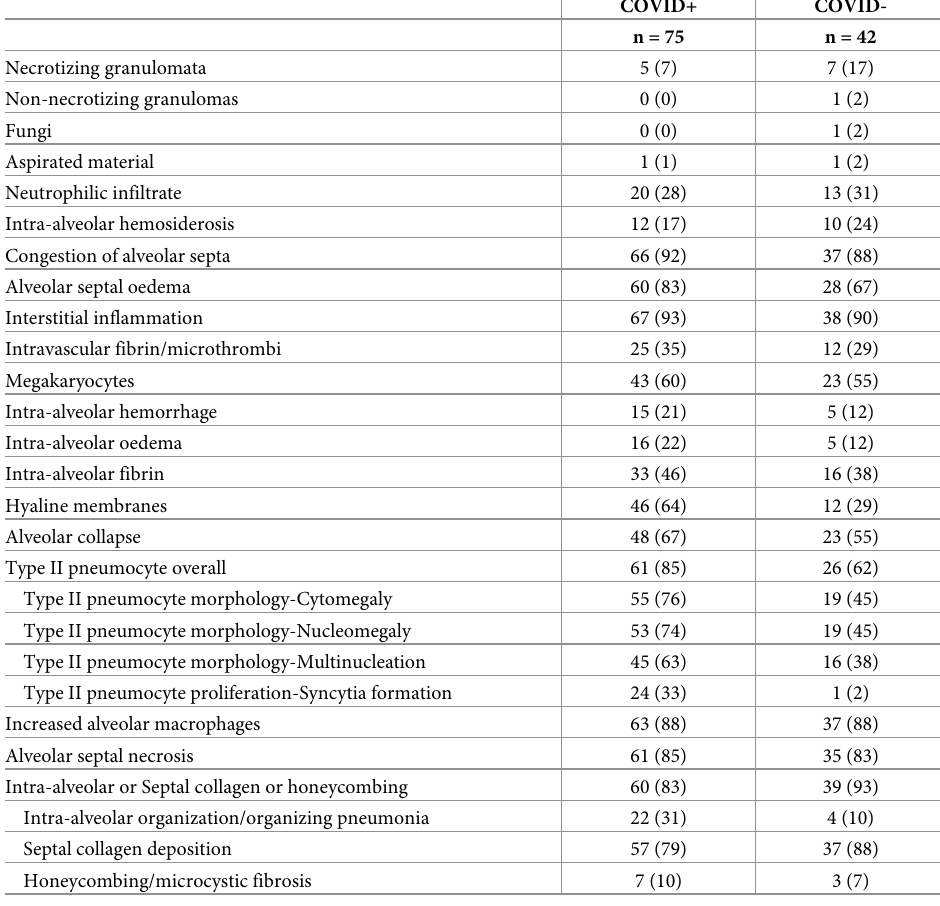
Honeycombing/microcystic fibrosis Results are n